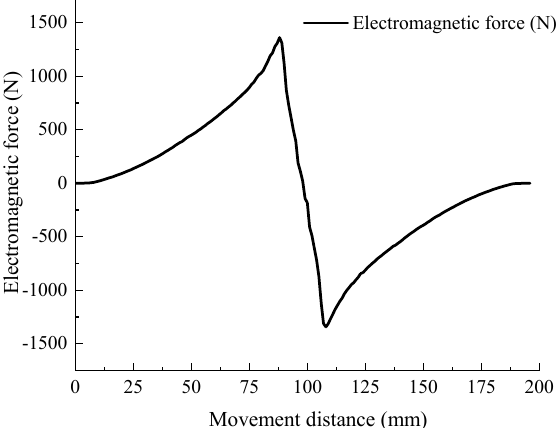
Figure 8. Electromagnetic force at different moving positions of the weft